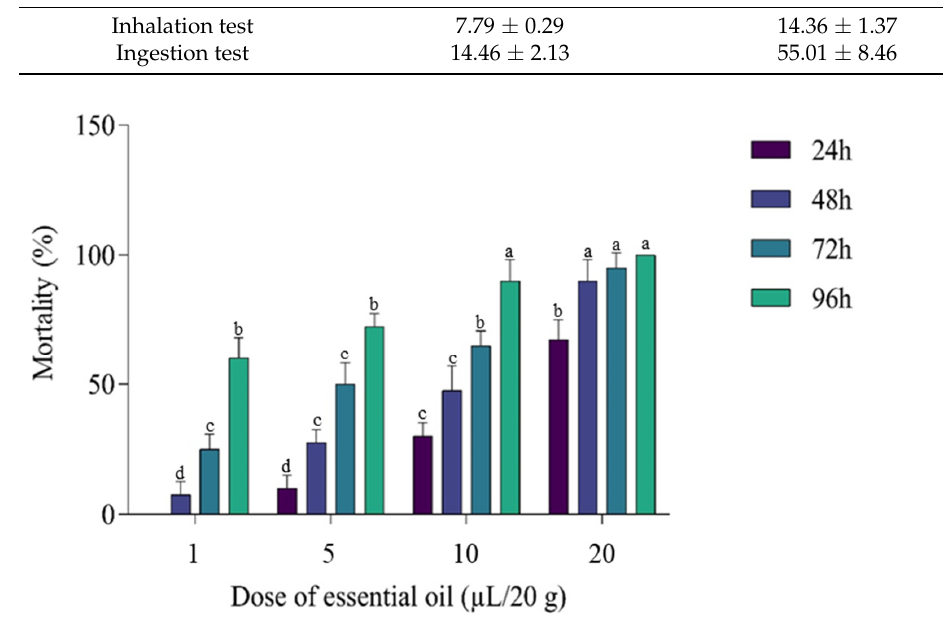
Figure 3. Mortality (%) of C. maculatus after ingestion of grains in presence of different doses of EO (µL EO/20 g). The test lasted four days, and the results were obtained at 24, 48, 72, and 96 h. All treatments had a significant effect compared with the control (0%). Bars with the same letters do not differ significantly ( p < 0.05) (Tukey’s HSD test). Results are expressed as mean ± SD.